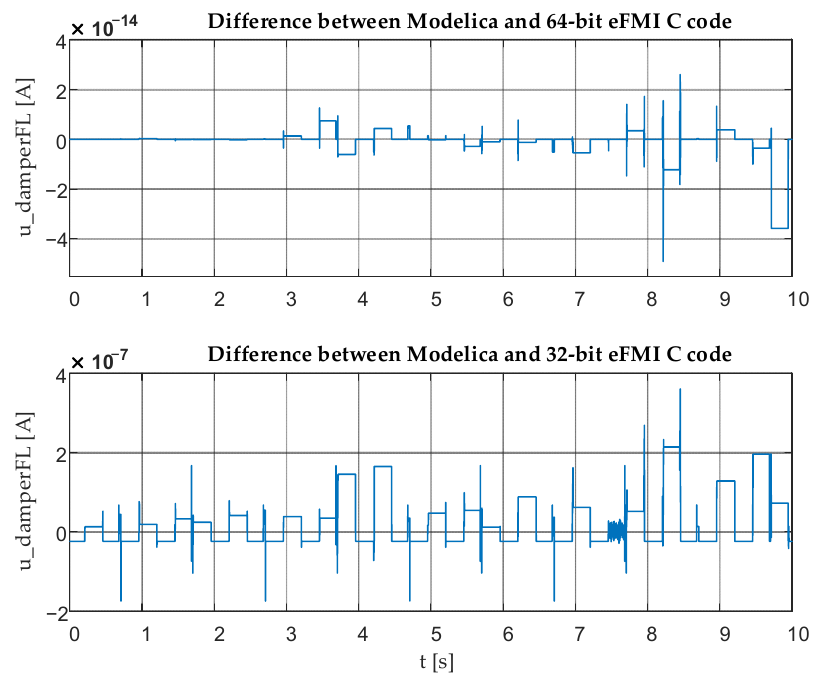
Figure 10. Test setup for open-loop tests to validate different parts of the eFMI workflow. The high-fidelity model described in Section 4.1 was used to create the synthetic excitation data.